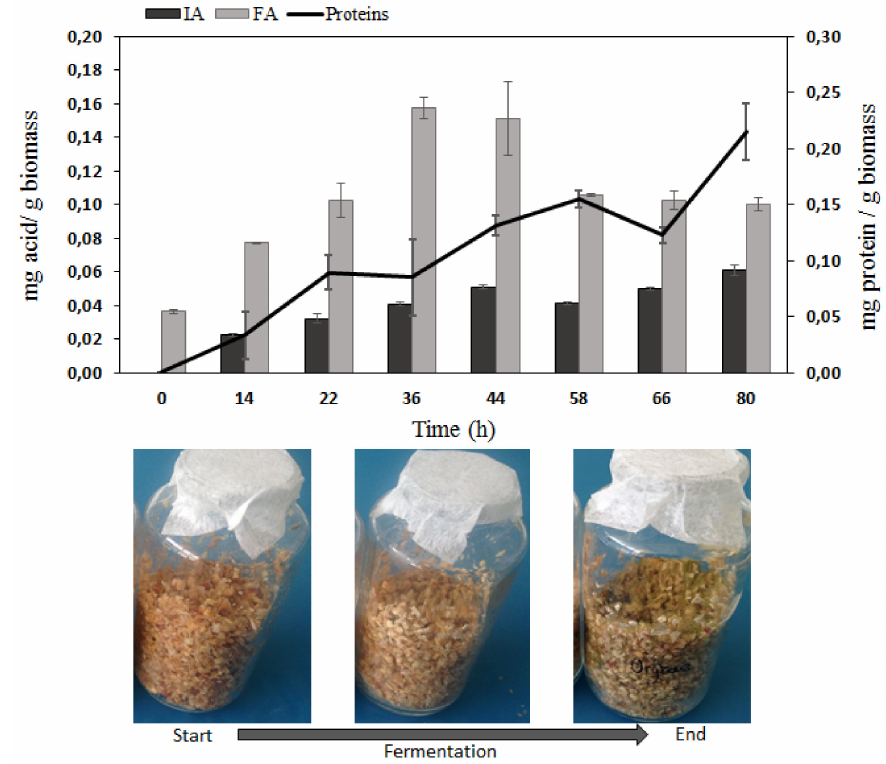
Figure 4. Kinetics of SSF on corn cobs by A. oryzae under optimized conditions (pH 6 and 110%